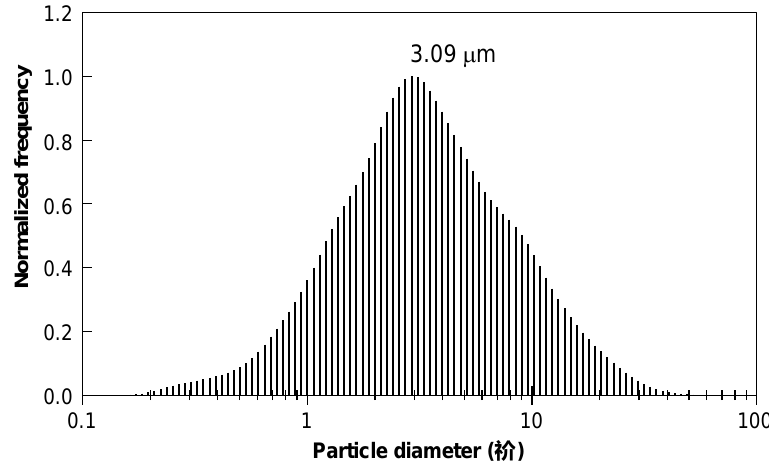
Figure 14. The particle size distribution for aerosolized 50Si·50BiF 3 powder passed through the feeder.